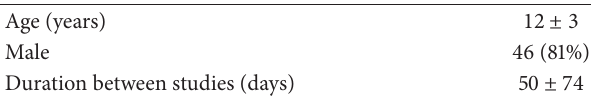
Table 1: Demographic information for study patients (median ± standard deviation).